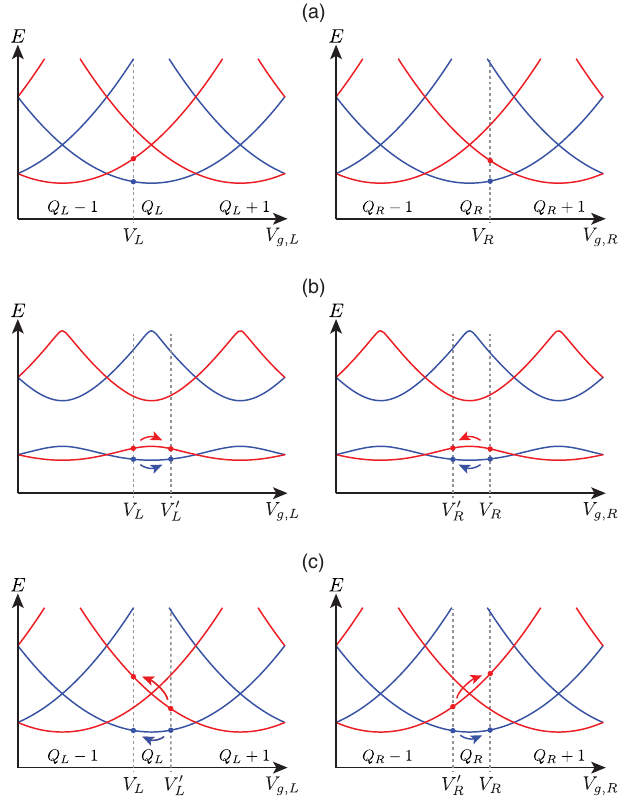
FIG. 8. Manipulations used to pump charge in the cycle sketched in Fig. 7(a). Each panel displays the energies versus gate voltage V on the left or right islands. The sequence g;L=R begins from the bottom configuration of Fig. 7(a), wherein the ; Q anyons fuse to yield a superposition of charge states j Q L R i − 1 ; Q 1 i ( ψ channel). Panel (a) denotes ( I channel) and j Q L R þ these charge states with circles and also indicates the initial gate voltages V . Next, one opens the outer valves, leading to the L=R energies in (b), and then sweeps the gate voltages to V 0 . L=R Closing the outer valves again and subsequently restoring the initial gate voltages as shown in (c) completes the desired ; Q pumping: j Q evolves trivially while the excited state L R i j Q L − 1 ; Q R þ 1 i changes to j Q L þ 1 ; Q R − 1 i . The latter evolution indicates charge 2 e flowing between the outer super- conductors when the fusion channel ψ − remains unchanged while the excited charge state j Q L 1 ;Q − 1 i . While the þ 1 i evolves into j Q þ 1 ; Q R L R former outcome is trivial, the latter corresponds to the left island borrowing a Cooper pair from the left grounded superconductor and the right island analo- gously shedding a Cooper pair rightward. In other words, we pump charge 2 e from left to right, but only if the anyons fuse into the ψ channel. At this point, the ; Q wave function collapses into either j Q i or j Q þ L R L 1 ; Q − 1 i with equal probability. In either case, open- R ing the middle valve evolves the system back into the state j Q i . We are now back at the top of our pumping tot cycle in Fig. 7(a) and ready to start anew.